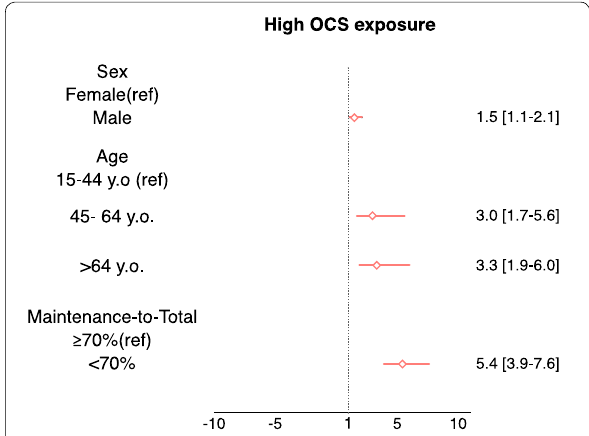
Fig. 3 Factors associated (adjusted OR [95% CI]) to high OCS